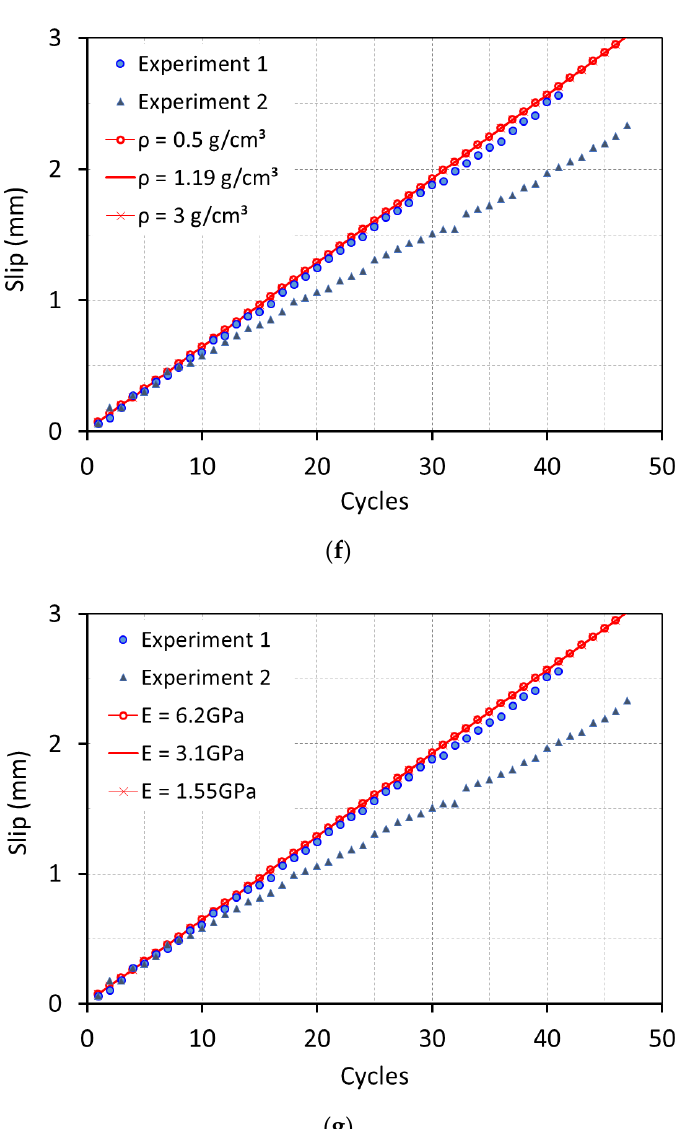
Figure 16. A parametric study with different inputs of temperature amplitude, elastic limit of the interface slip, and ther- mal expansion coefficient in ( a ), ( b ), and ( c ). The base case is set to ∆𝑇 = 23 ℃ and 𝛽 = 5° slope with the parameters in Table 1. Two experimental test results (1 and 2) for the base case are from Figure 2. A parametric study with different inputs of slope angle, friction coefficient, and acryl density in ( d ), ( e ), and ( f ). The base case is set to ∆𝑇 = 23 ℃ and 𝛽 = 5° slope with the parameters in Table 1. A parametric study with different inputs of Young’s modulus in ( g ). The base case is set to ∆𝑇 = 23 ℃ and 𝛽 = 5° slope with the parameters in Table